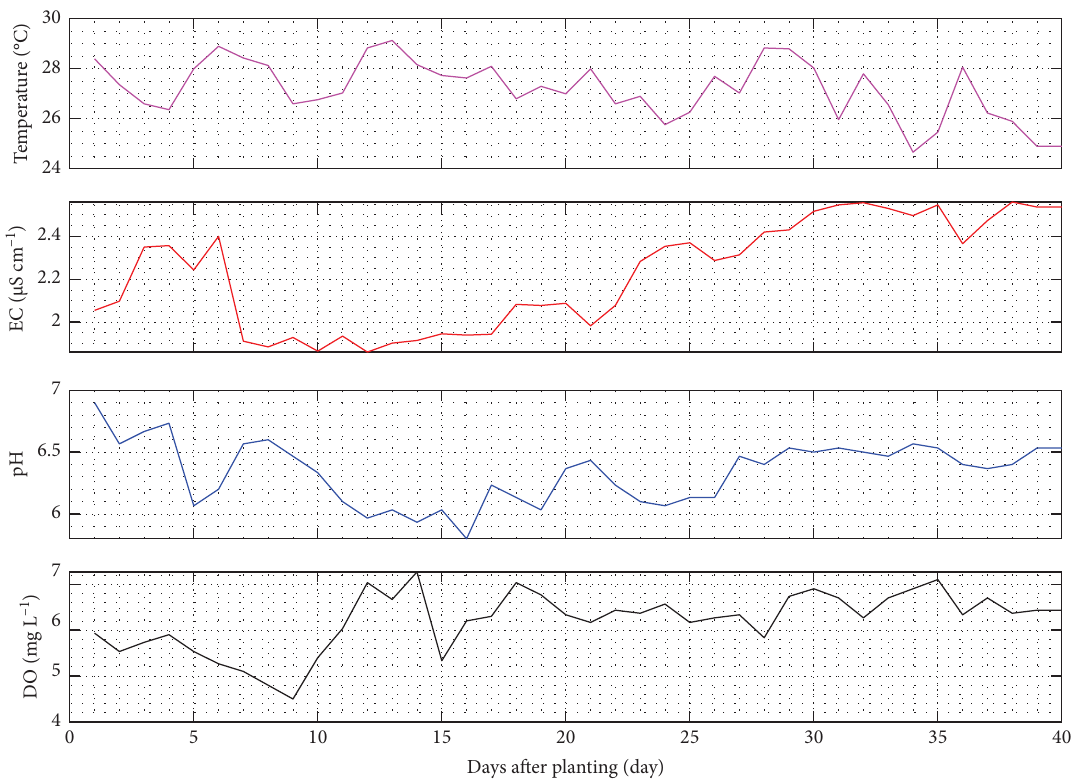
Figure 10: Nutrient parameters of the self-fertigation system during mustard pagoda